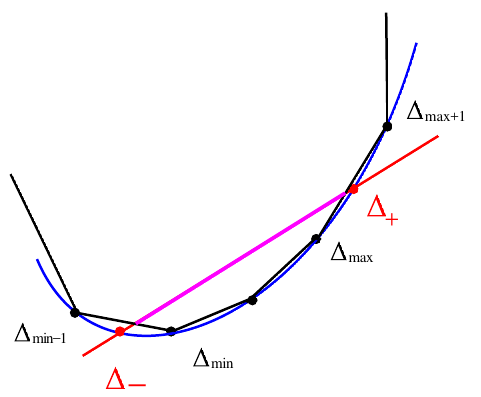
Figure 13 . For a putative spectrum the four point function is bounded by the operators that are the closest to (cid:1) (cid:0) ; (cid:1) + f g